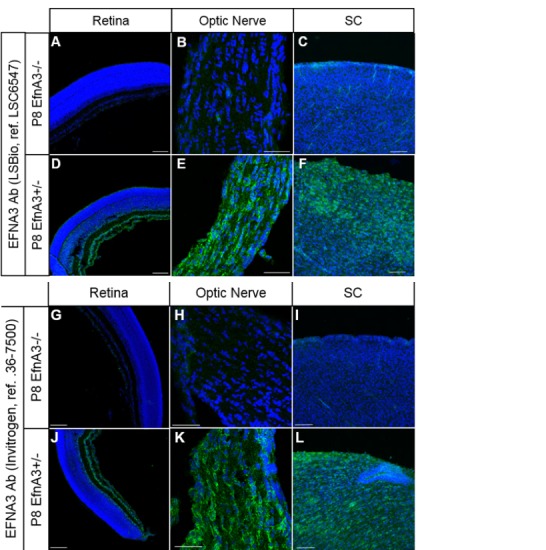
Immunohistochemistry on P8 Efna3-/- (A, B, C, G, H, I) and Efna3+/- (D, E, F, J, K, L) tissue sections using EFNA3 antibodies from LSBio (LSC6547) (A-F) and Invitrogen (36-7500) (G-L).Scale bars, 100µm (A, C, D, F, G, I, J, L), 50 µm (B, E, H, K).